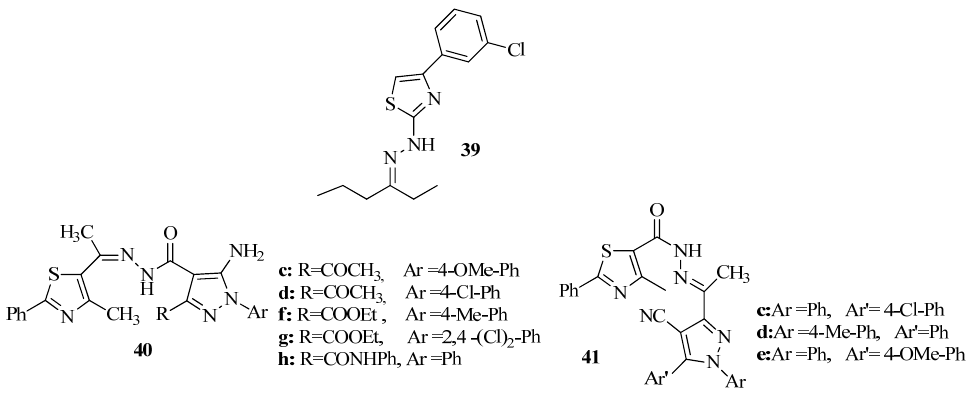
Figure 15. Structure of compounds.